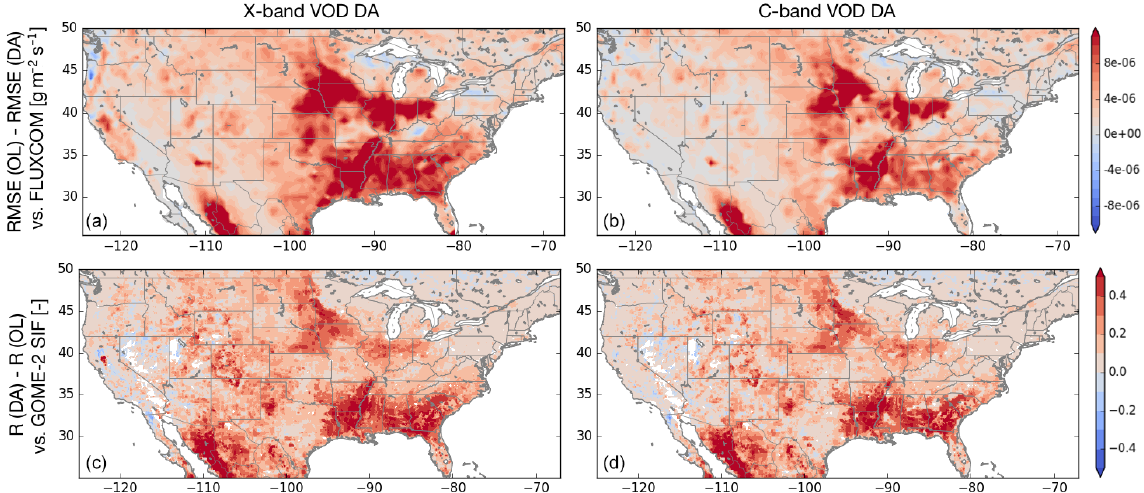
Figure 4. Changes in RMSE of GPP (expressed as RMSE(OL) − RMSE (DA)) in units of gm − 2 s − 1 using the FLUXCOM data as the reference (a, b) and R of modeled GPP with solar-induced fluorescence data from GOME-2 (c, d) , expressed as R (DA) − R (OL). The warm colors represent improvements from DA and cool colors represent degradations resulting from